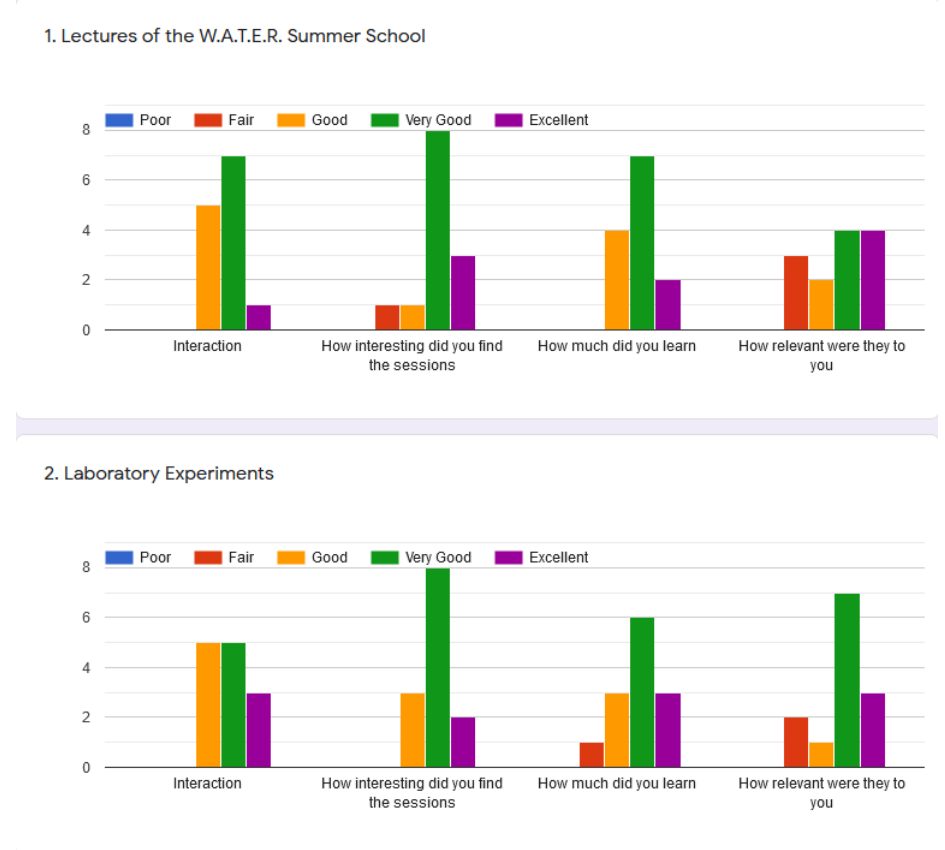
Figure 8. Results of the evaluation by the participants of W.A.T.E.R.